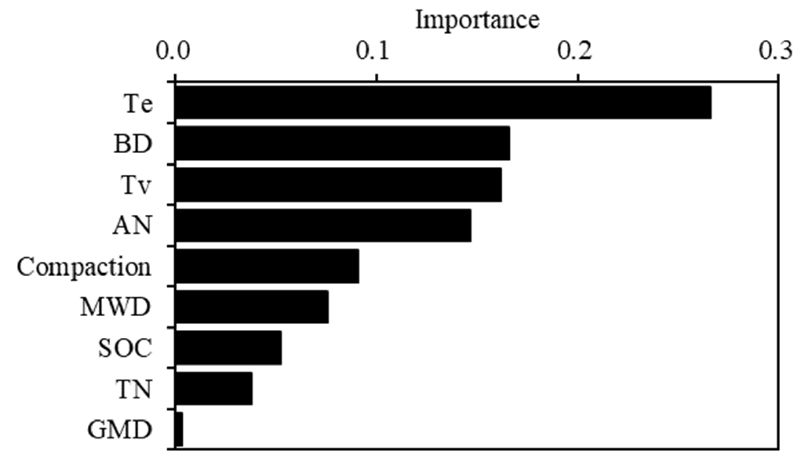
Figure 10. The importance of soil properties at the 0–20 cm soil depth on maize grain yield. Te, mean soil temperature during emergence to V4 of maize; BD, soil bulk density; Tv, mean soil temperature during V5 to V11 of maize; AN, available nitrogen, including ammonium nitrogen and nitrate nitrogen; Compaction, mean soil compaction; MWD, soil mean weight diameter; SOC, soil organic carbon; TN, soil total nitrogen; GMD, soil geometric mean